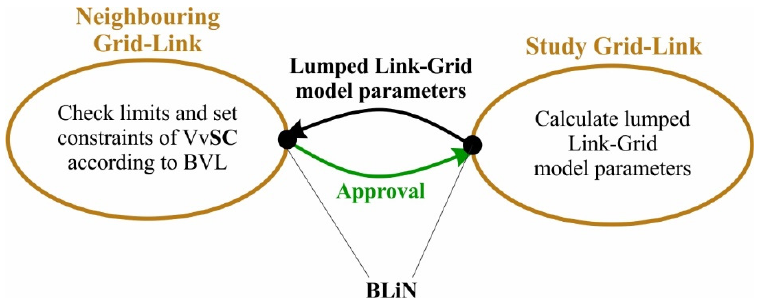
Figure 19. Generalized use case for the boundary voltage limits.